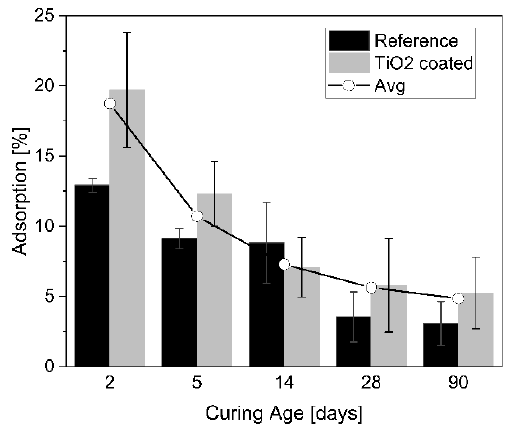
Figure 3. Variation of adsorption by curing age for reference and TiO 2 coated specimens.